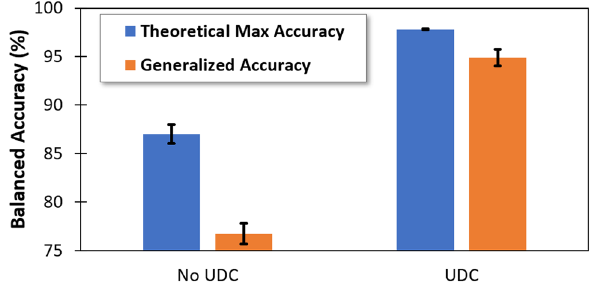
Figure 2. Balanced accuracy before and after UDC. The orange bar represents the AI accuracy on the test dataset using the standard AI training practice. The blue bar represents the theoretical maximum AI accuracy possible on the test dataset. The discrepancy between these two values is indicative of the generalizability of the model.